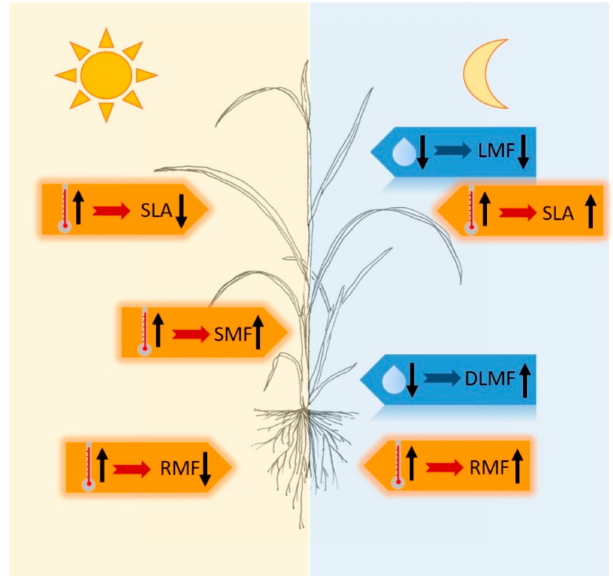
Figure 4. E ff ects of temperature and relative air humidity during day and night on dry matter partitioning and specific leaf area in rice. Orange pentagons represent temperature e ff ects, blue pentagons represent e ff ects of relative air humidity. Arrow up: high; arrow down: low. Abbreviations: LMF: leaf mass fraction; SMF: stem mass fraction; RMF: root mass fraction; DLMF: fraction of dead leaves; SLA: specific leaf area.